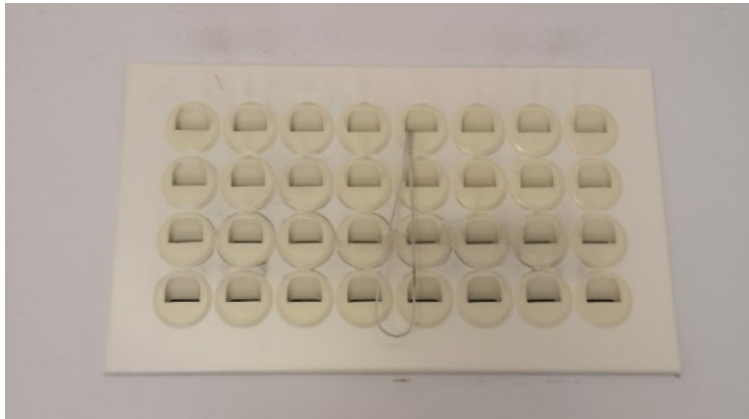
Figure 4. An air supply device with nozzles directed upwards towards the ceiling.